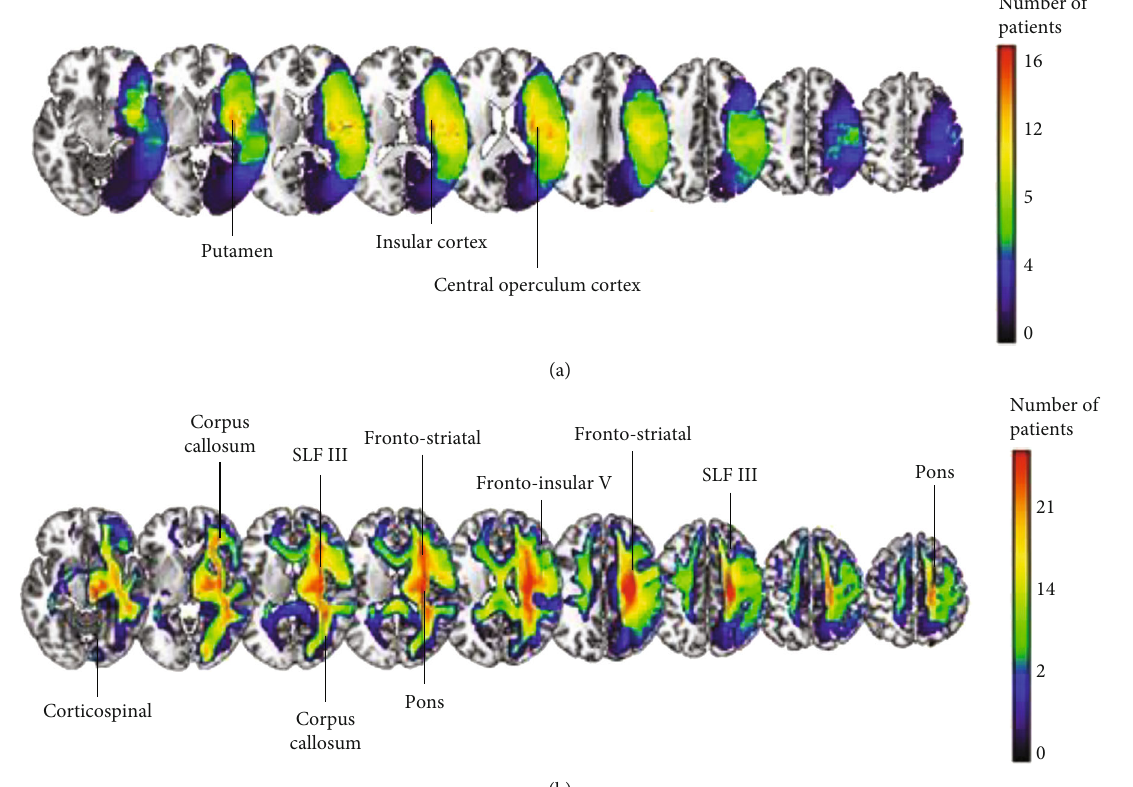
Figure 2: Overlay maps of lesions (a) and white-matter disconnections (b) on a standard brain MNI template. The color scale represents the number of